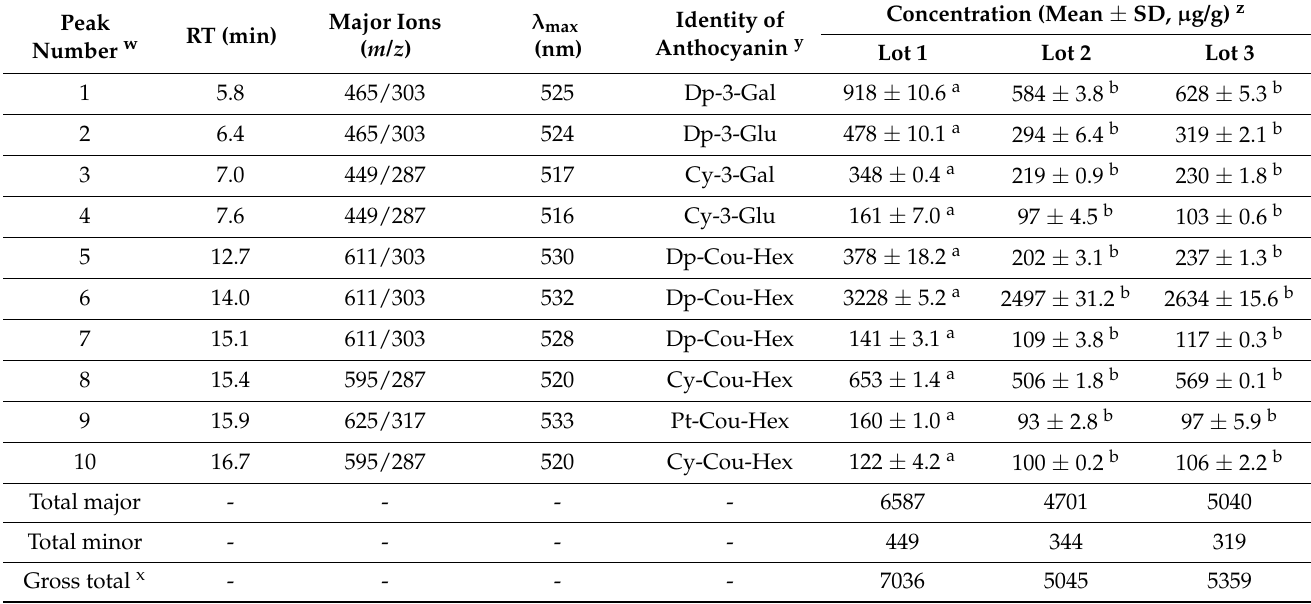
Table 2. Chromatographic and mass characteristics and concentration of major anthocyanin pigments in purple tea